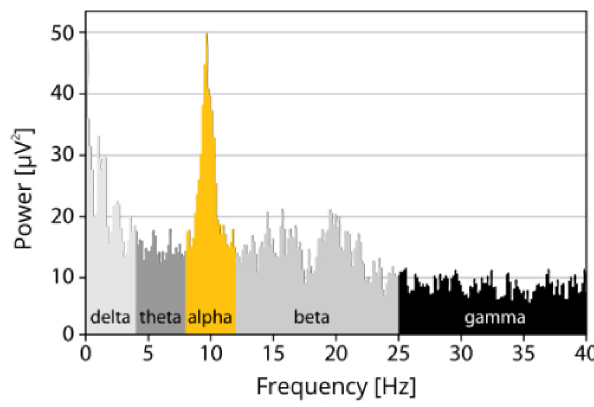
Figure 5. Power analysis of an EEG signal by means of the Fast Fourier Transform (FFT).